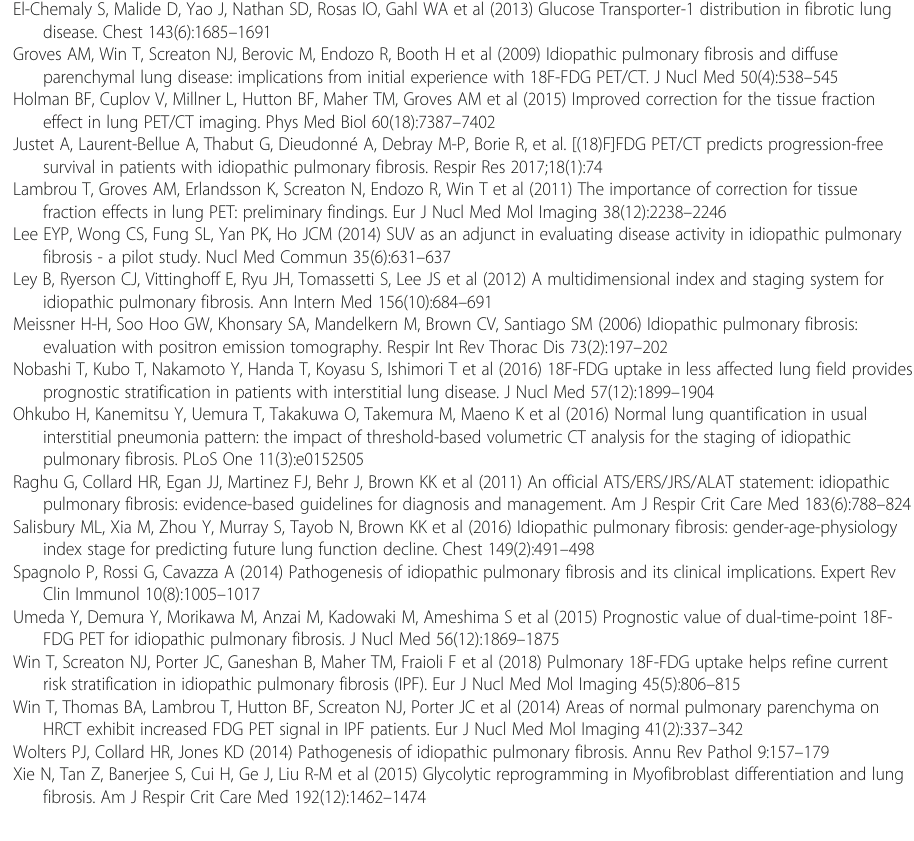
FDG PET for idiopathic pulmonary fibrosis. J Nucl Med 56(12):1869 – 1875 Win T, Screaton NJ, Porter JC, Ganeshan B, Maher TM, Fraioli F et al (2018) Pulmonary 18F-FDG uptake helps refine current risk stratification in idiopathic pulmonary fibrosis (IPF). Eur J Nucl Med Mol Imaging 45(5):806 – 815 Win T, Thomas BA, Lambrou T, Hutton BF, Screaton NJ, Porter JC et al (2014) Areas of normal pulmonary parenchyma on HRCT exhibit increased FDG PET signal in IPF patients. Eur J Nucl Med Mol Imaging 41(2):337 – 342 Wolters PJ, Collard HR, Jones KD (2014) Pathogenesis of idiopathic pulmonary fibrosis. Annu Rev Pathol 9:157 – 179 Xie N, Tan Z, Banerjee S, Cui H, Ge J, Liu R-M et al (2015) Glycolytic reprogramming in Myofibroblast differentiation and lung fibrosis. Am J Respir Crit Care Med 192(12):1462 –